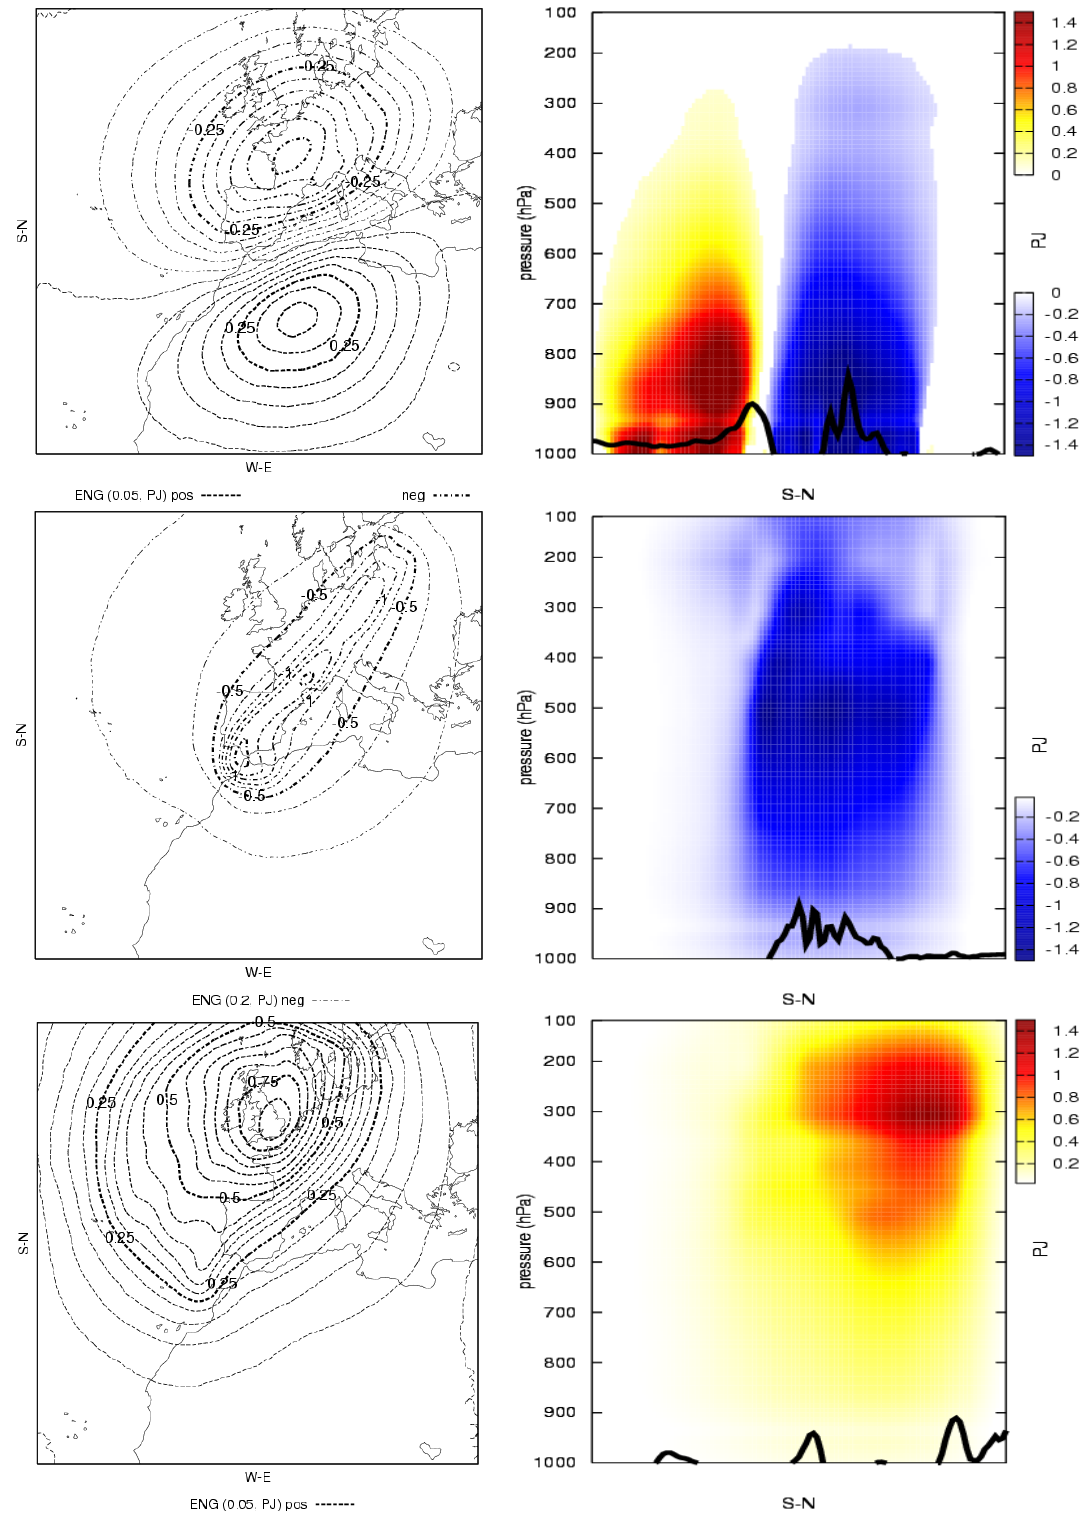
Fig. 8. Energy variations (PJ) introduced after the modification of the initial conditions (10 November 2001 at 00:00UTC), according to each positive percentage of modification of the PV Inverted fields of each anomaly; ErPVpTerm (top), ErPVp01 (middle), ErPVpHigh (bottom). At 500hPa (left) and following vertical cross sections defined at Fig. 6